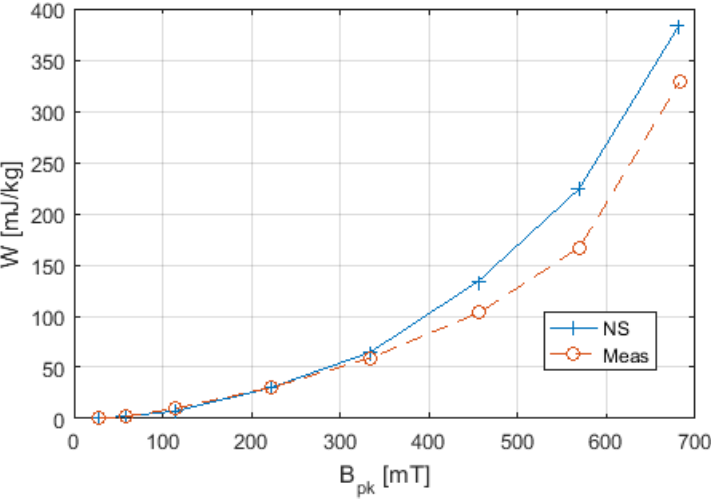
Figure 12. Comparison of the simulated and measured energy-loss curves relative to the two-tone magnetic inductions (SET 3).